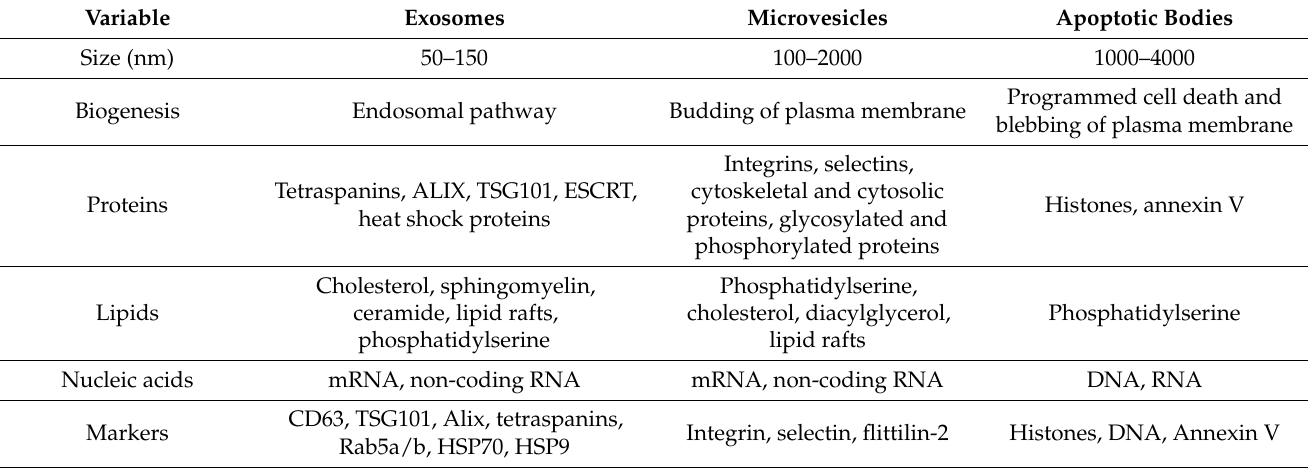
Table 1. Main types and characteristics of extracellular